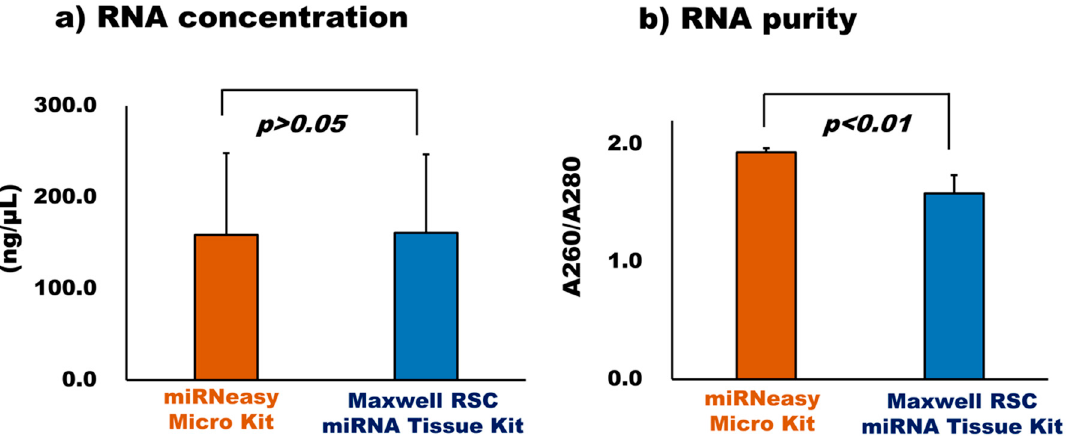
Figure 2. Comparison of RNA concentration ( a ) and RNA purity ( b ) in milk sEVs extracted by miRNeasy Micro Kit and Maxwell RSC miRNA Tissue Kit. Data are presented as a mean value for each kit. There was no significant difference in RNA concentration between the two kits. However, RNA purity was higher and significantly different in miRNeasy Micro Kit (A260/A280: 1.93) than that in Maxwell RSC miRNA Tissue Kit (A260/A280: 1.58) ( p <